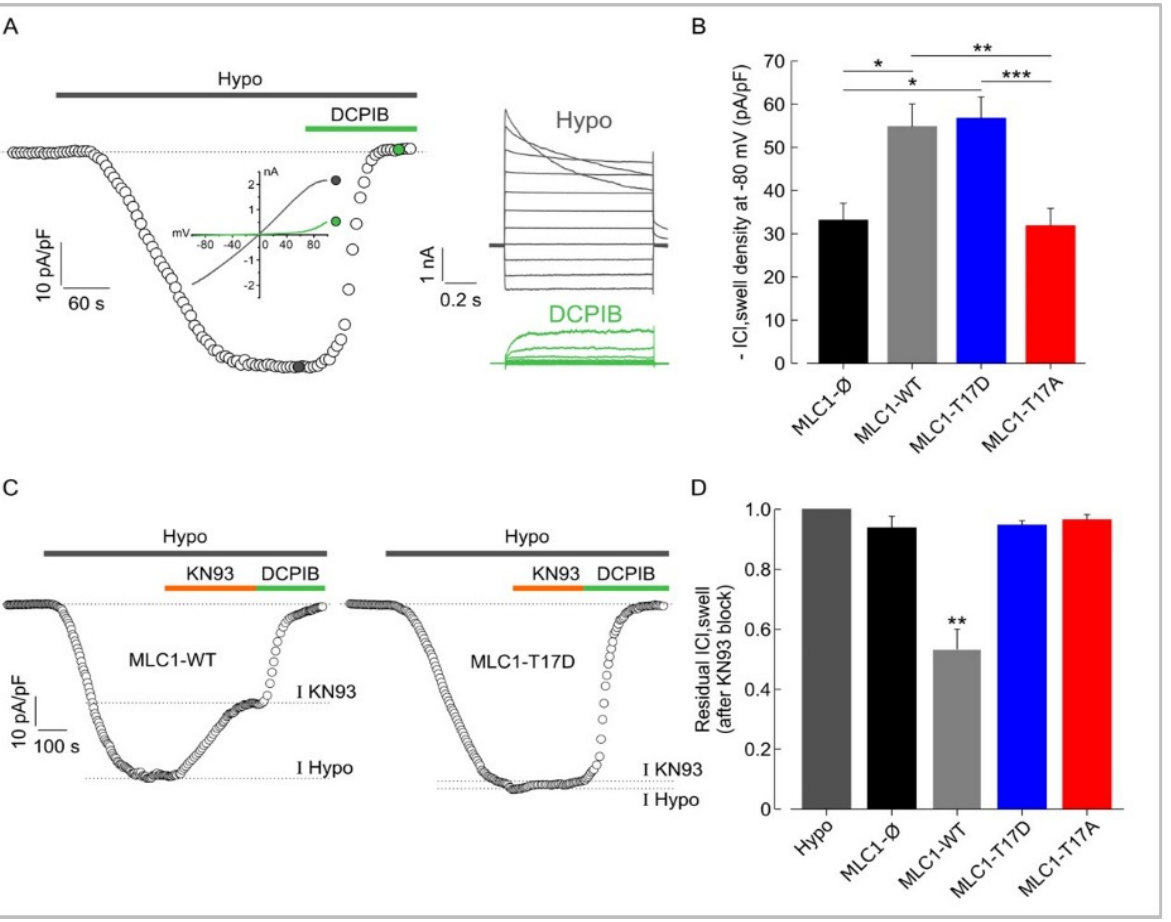
Figure 5. Phosphorylation of MLC1-T17 potentiates ICl, swell in U251 cells. ( A ) Representative time course of ICl, swell density (pA/pF) measured at − 80 mV (the equilibrium potential for K+ under our recording conditions), taken from current ramps (from − 100 to 100 mV, 600 ms duration, holding potential − 40 mV) applied during the application of hypotonic solution (grey trace) and upon addition of 10 µ M DCPIB (green trace). Right: families of current traces evoked by applying 1 s voltage steps from − 100 to 100 mV, in steps of 20 mV (HP − 40 mV) in the presence of a hypotonic solution (grey traces), and upon addition of 10 µ M DCPIB (green traces). ( B ) Bar plot showing the average current density measured at − 80 mV during exposure to 30% hypotonic solution, in U251 cells transfected with the empty vector (MLC1-Ø, n = 10), with MLC1-WT protein ( n = 14), and with MLC1-T17D (phosphorylation mimicking mutant, n = 9) or MLC1-T17A (not phosphorylatable mutant, n = 14). ( C ) Representative time courses of ICl, swell density (pA/pF) measured at − 80 mV from current ramps, during application of hypotonic solution (grey bar) and upon addition of 10 µ M KN93 and 10 µ M DCPIB, in MLC1-WT ( left ) and MLC1-T17D ( right ) U251 cells. The dashed lines in the time courses indicate the levels where the peaks of currents were measured. ( D ) Bar plot showing the mean residual ICl, swell in the presence of 10 µ M KN93, as normalized to the ICl, swell elicited during exposure to 30% of hypotonic solution in the absence of the KN93 (Hypo), in the different cell lines (Mean ± SEM n = 3–5; * p < 0.05; ** p < 0.01, *** p <